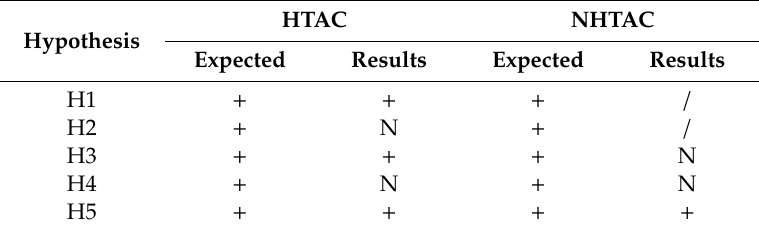
Table 9. The comparison between hypotheses and empirical results. HTAC NHTAC Hypothesis Expected Results Expected